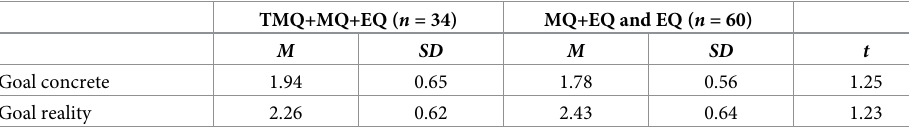
A randomized controlled trial (RCT) experiment was conducted to examine the effects of TMQ, and the results showed that the worksheet consisting of the TMQ, MQ, goal-setting and EQ increased time-orientation. In contrast, solution-building and positive and ideal levels of life increased after implementation, regardless of the content of the work. In addition, Table 3. Differences in the nature of goals depending on whether the TMQ is